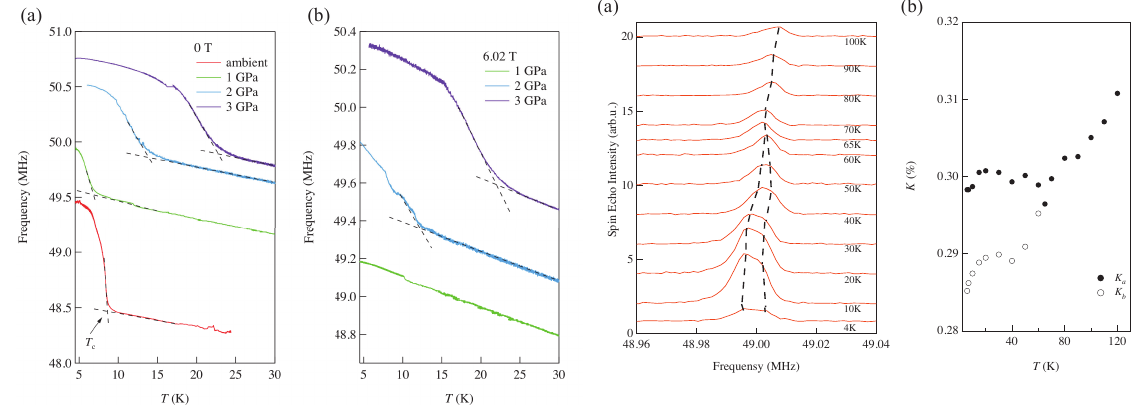
Figure 2: (a) The T evolution of 77 Se spectrum at am- bient pressure. The black dashed line shows peak fre- quencies. (b) The 77 Se shift at ambient pressure deter- mined from a single Gaussian fit. K a and K b reflect the high and low frequency peak,